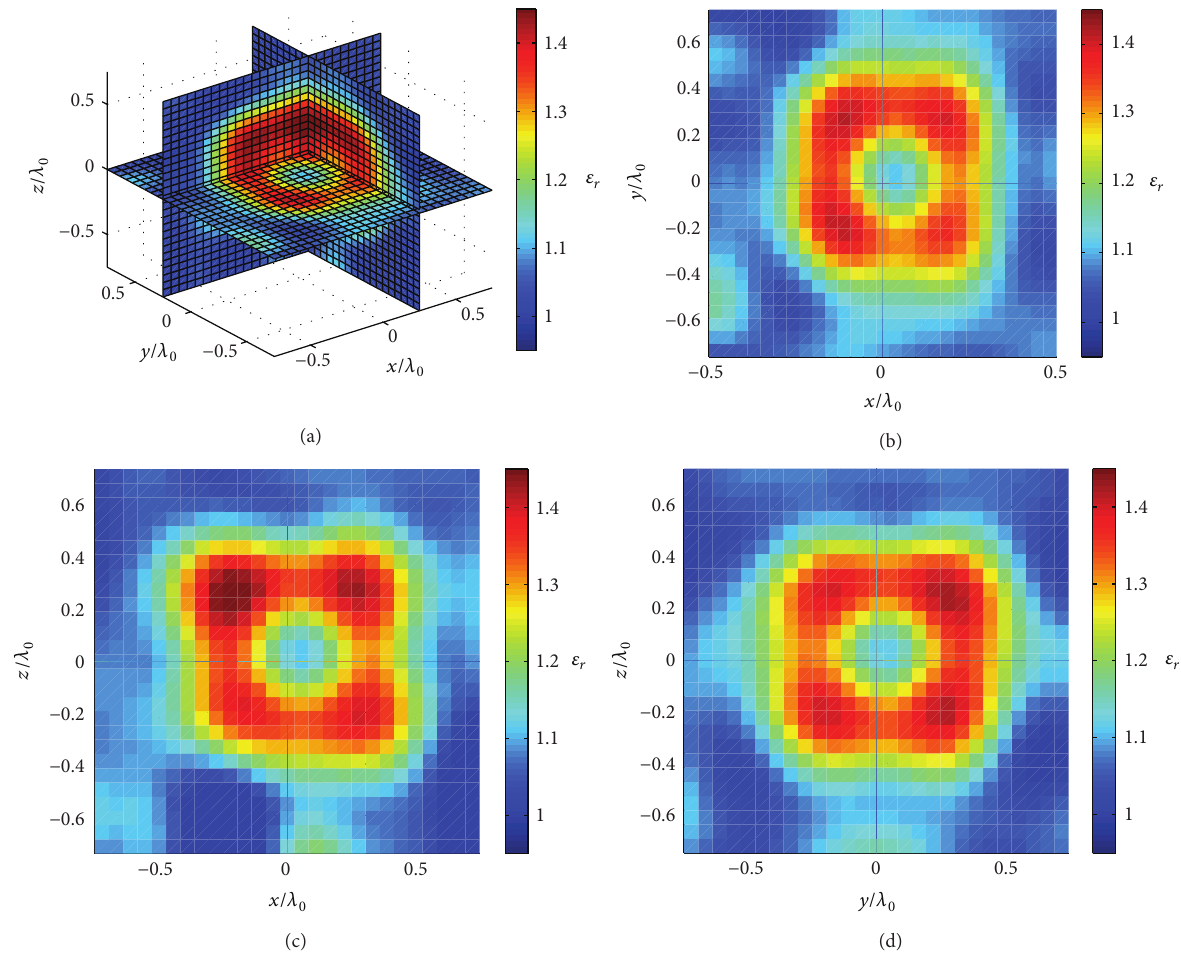
Figure 4: Reconstructed distribution of the relative dielectric permittivity. (a) 3D view; (b) 𝑥𝑦 plane ( 𝑧 = 0 ); (c) 𝑥𝑧 plane ( 𝑦 = 0 ); (d) 𝑦𝑧 plane ( 𝑥 = 0 ). Dielectric cube with a void inclusion. SNR = 25 dB. 𝐿 = 2